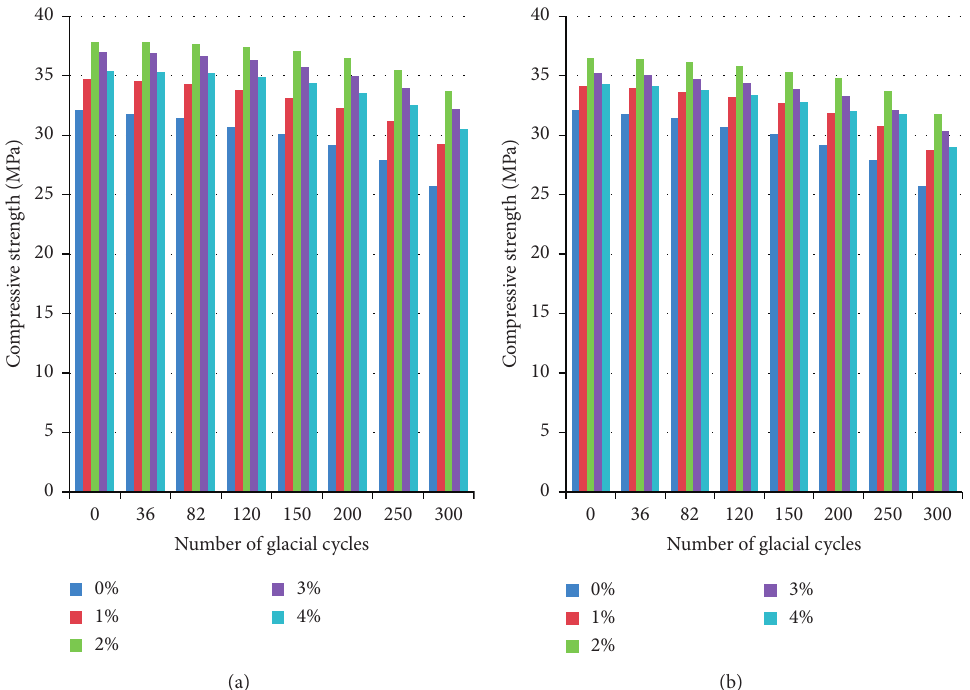
Figure 7: Compressive strength of samples under different freeze-thaw cycles: (a) GO/Al